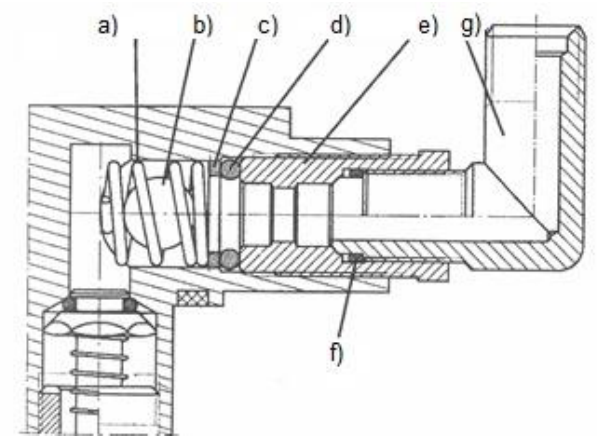
Fig. 3. Multivalve check valve [2]: a) spring, b) ball, c) washer, d) rubber sealing ring, e) reduction sleeve, f) rubber sealing ring, g) elbow fitting